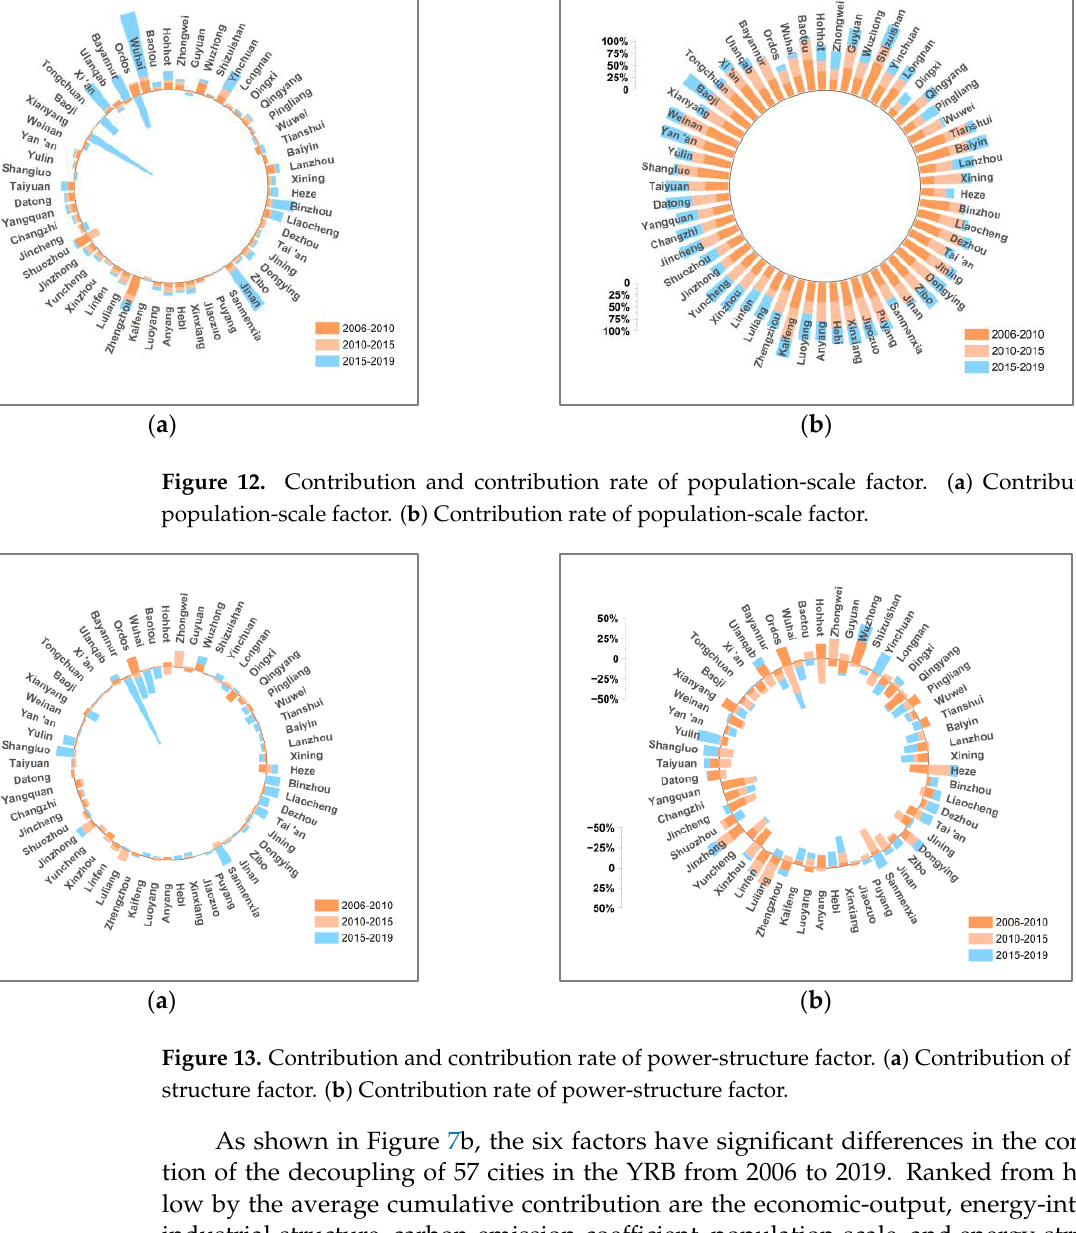
of carbon-emission-coefficient factor. ( b ) Contribution rate